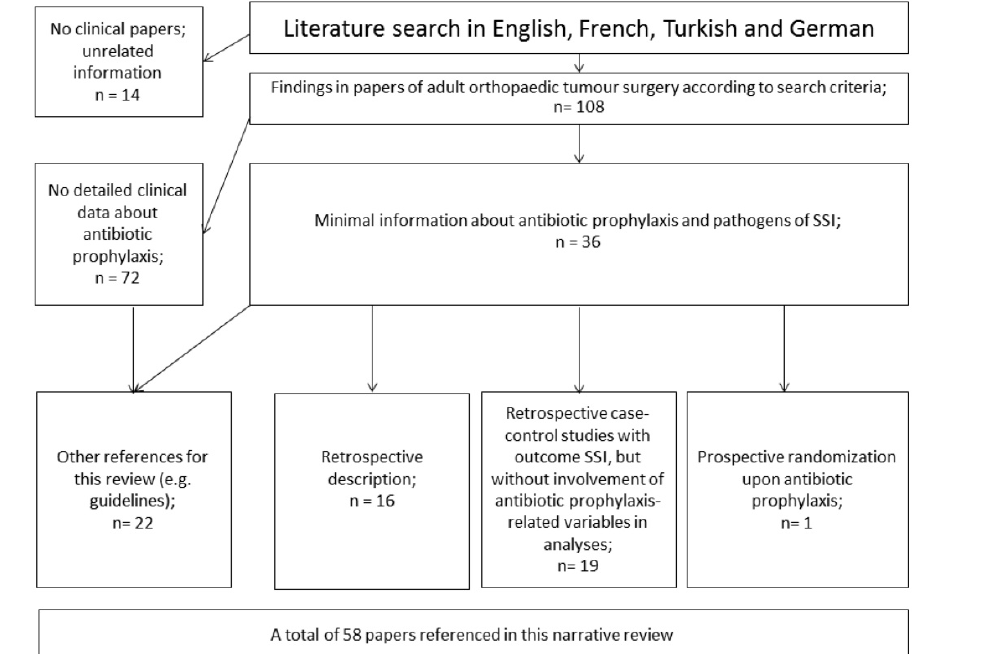
Figure 1: Flowchart of the literature